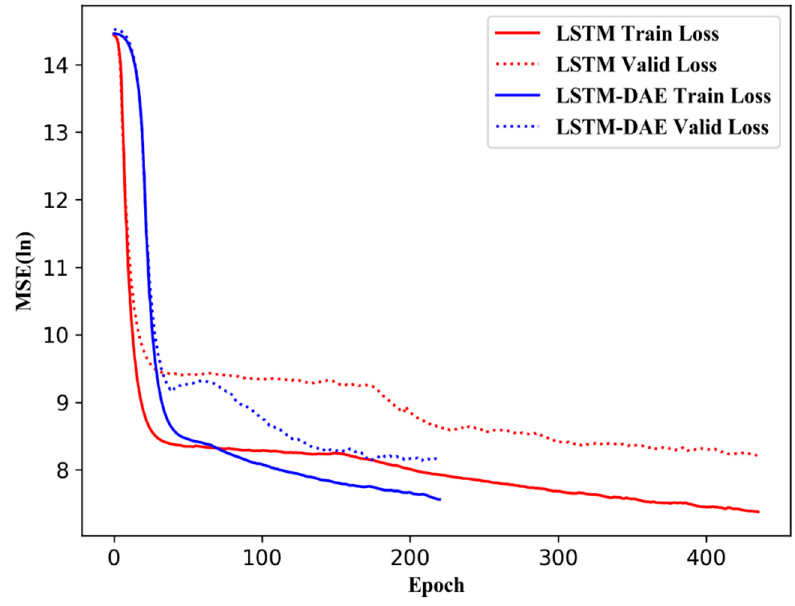
Figure 10. Cost function with respect to training and the test data set.